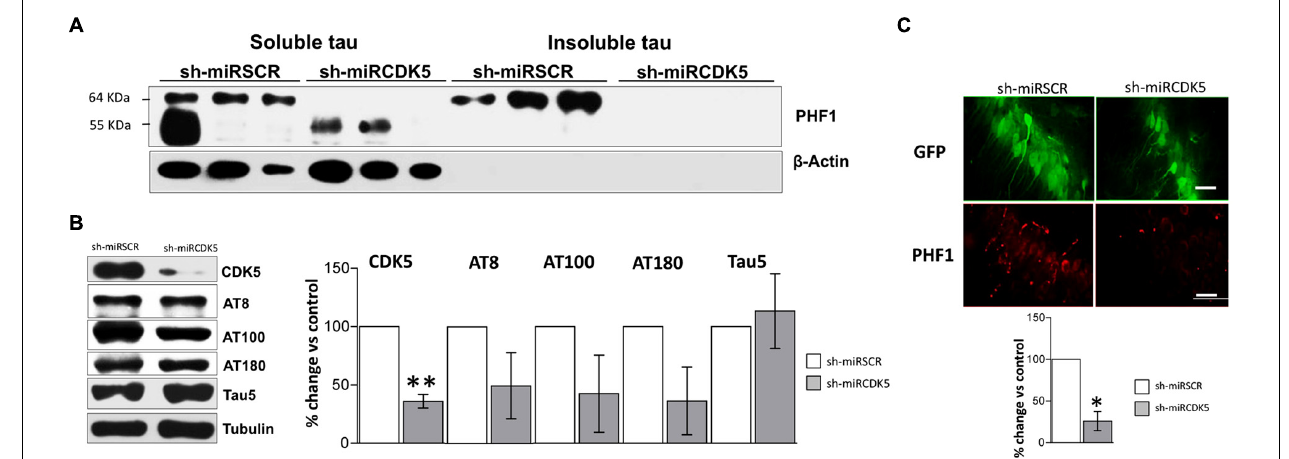
decrease. Representative blots are shown.Tubulin was used as loading control. Densitometry quantification was done. n = 3, * p < 0.05, ** p < 0.01. (C) Quantification of PHF1 evaluated by immunofluorescence in CA1 revealed that shCDK5miR decreased the intensity of fluorescence in 3xTg-AD mice. PHF1 in red (Alexa 594) and GFP in green. Magnification 60 × . Scale bar, 50 μ m; n = 3; * p < 0.05, ** p < 0.01. Densitometry quantification was done. n = 3, * p < 0.05, ** p <